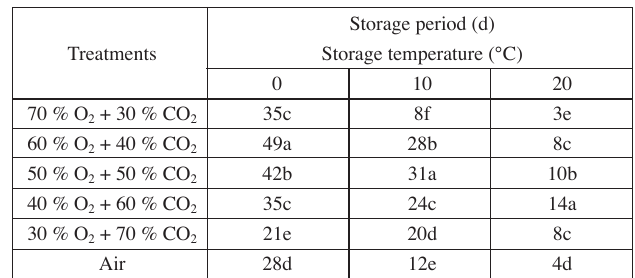
Tab. 1: Storage period of broccoli florets treated with varied O 2 /CO 2 concen- tration under different temperature. Different little letters indicates that there is significant difference among